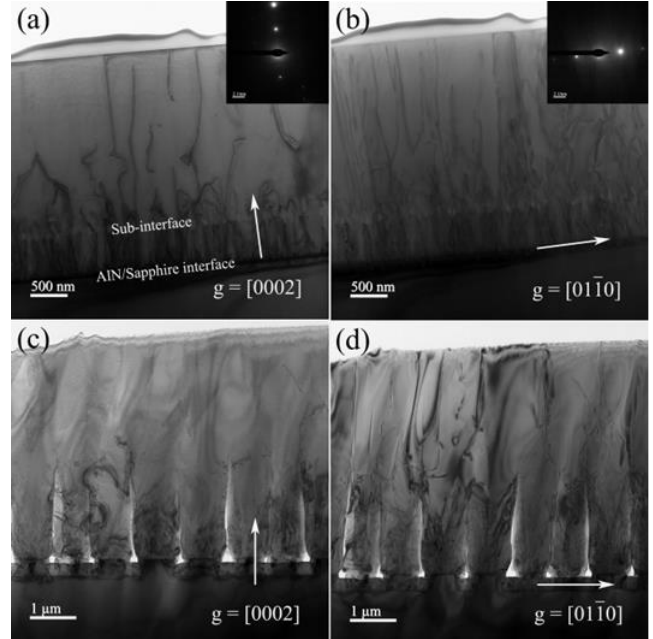
Figure 3. Bright-field cross-sectional TEM images of AlN/Sapphire sample Sc ( a , b ) and Sp ( c , d ) along with g = [0002] and g = [011̅0] .